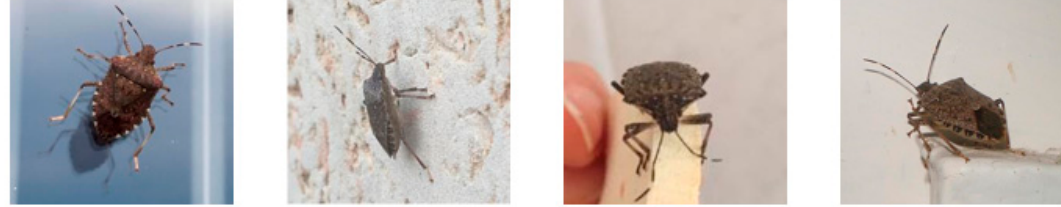
Figure 1. Pictures of brown marmorated stink bug taken from different angles.